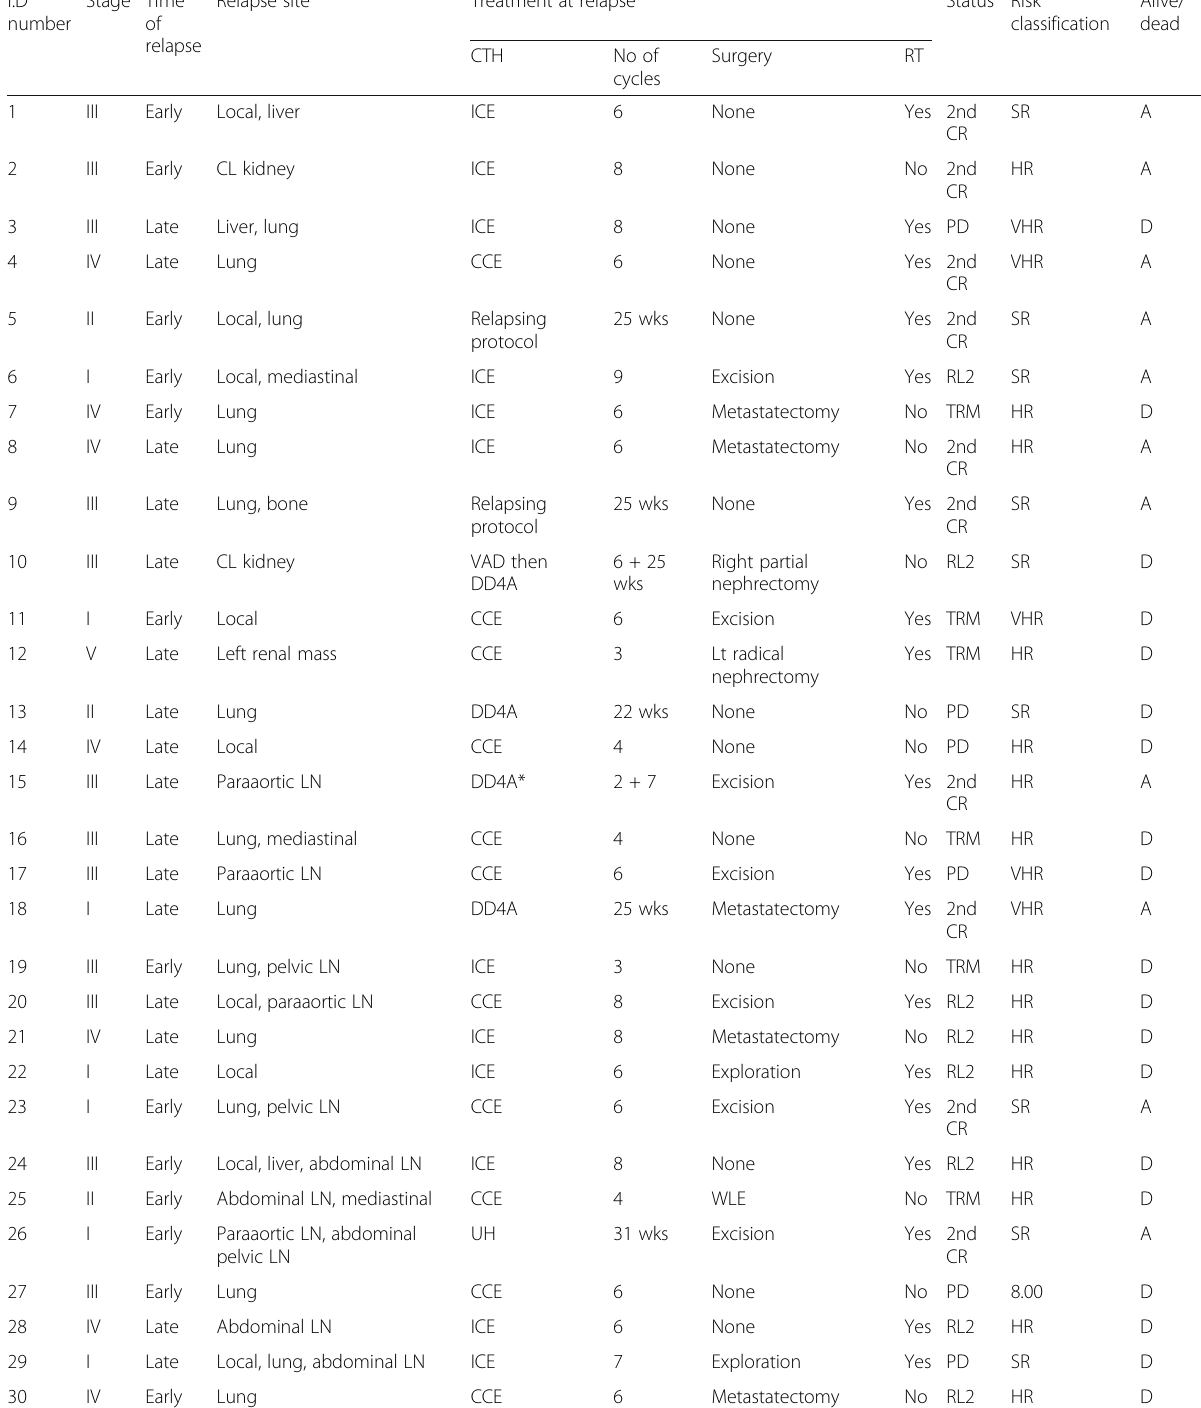
Table 2 Description of the whole study group regarding different prognostic variables and survival I.D Stage Time number